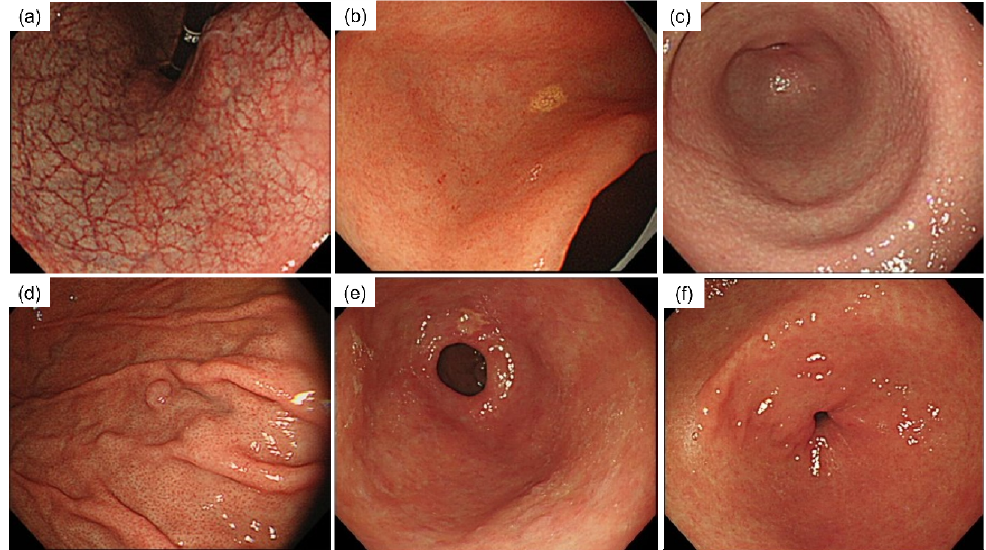
Figure 1. Essential endoscopic findings. ( a ) Endoscopic atrophic gastritis (Open type); ( b ) xanthoma; ( c ) nodular gastritis; ( d ) fundic gland polyp; ( e ) incompetent pylorus; ( f ) normal pylorus.